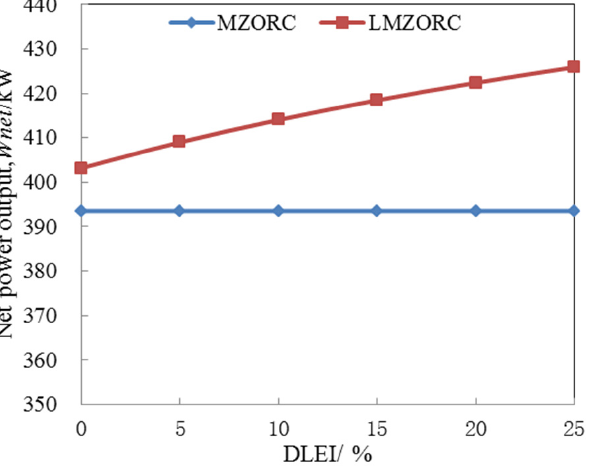
Figure 15. W net of LMZORC and MZORC at different DLEIs [75]. Reproduced with permission from Luo et al., Energy Conversion and Management; published by Elsevier, 2018.